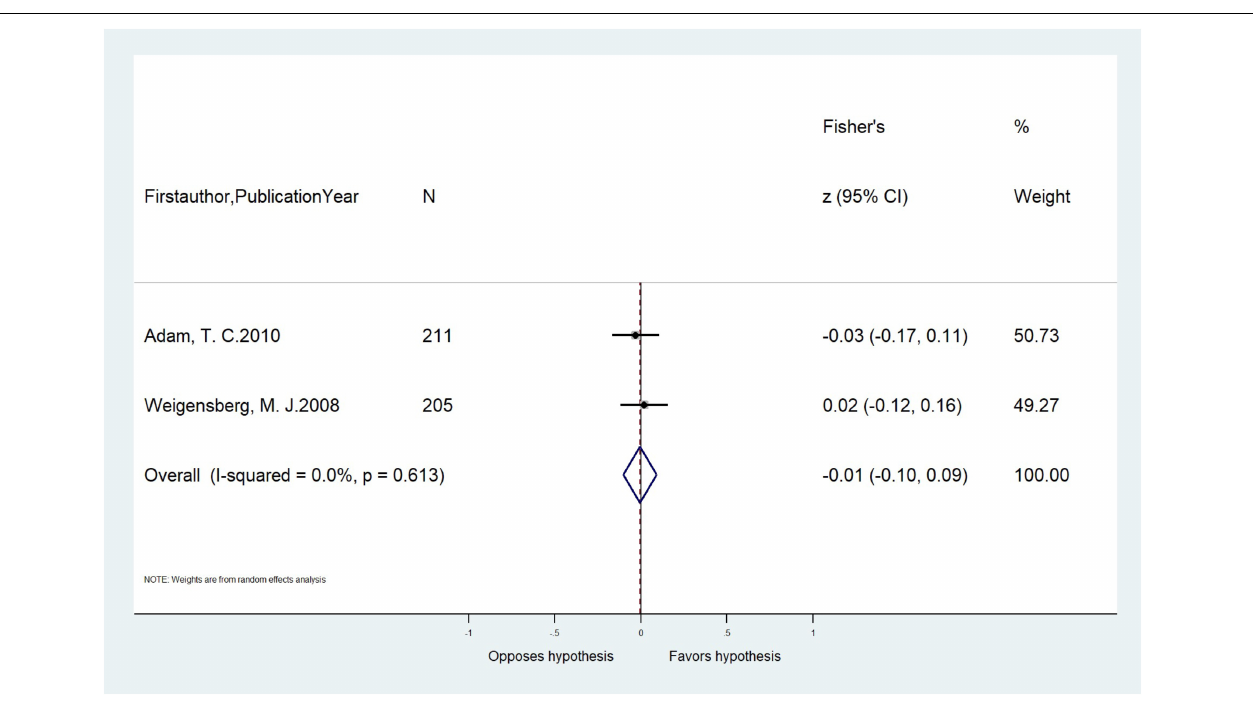
were longitudinal, precluding similar inferences on the direction of these associations. More longitudinal studies are needed to understand these